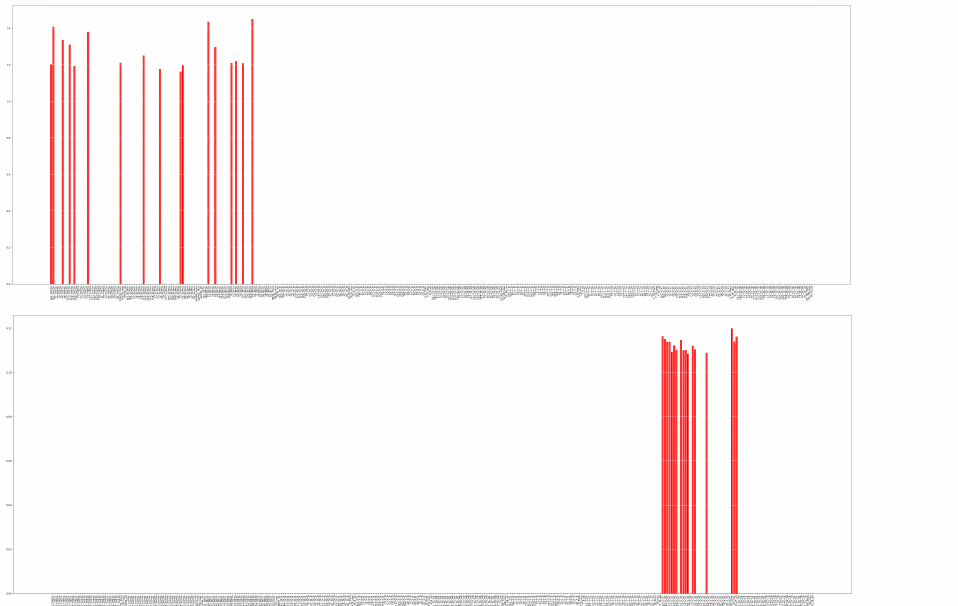
Figure 12. Selected TOP 5% features by the proposed algorithm ( up ) and by PCA ( bottom